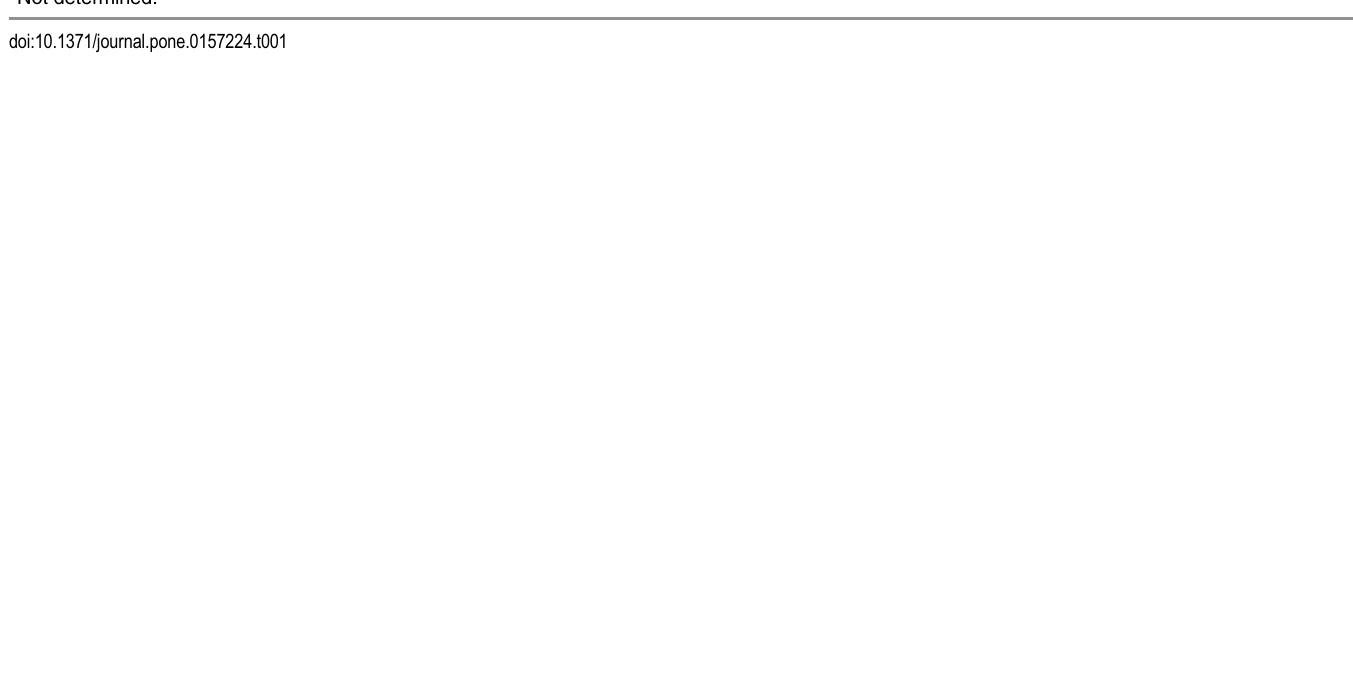
1 Upper case letters represent the 15 bp core Fis binding site sequence and those in lower case represent fl anking DNA. Underlined and bold nucleotides highlight those that differ from F1.